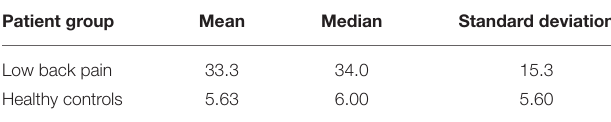
TABLE 2 | ODI scores for each patient group. Patient